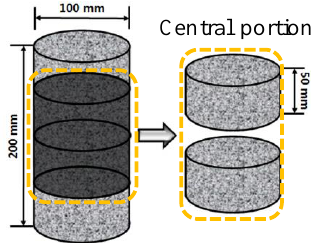
Figure 1. Schematic diagram of specimen for chloride penetration test.